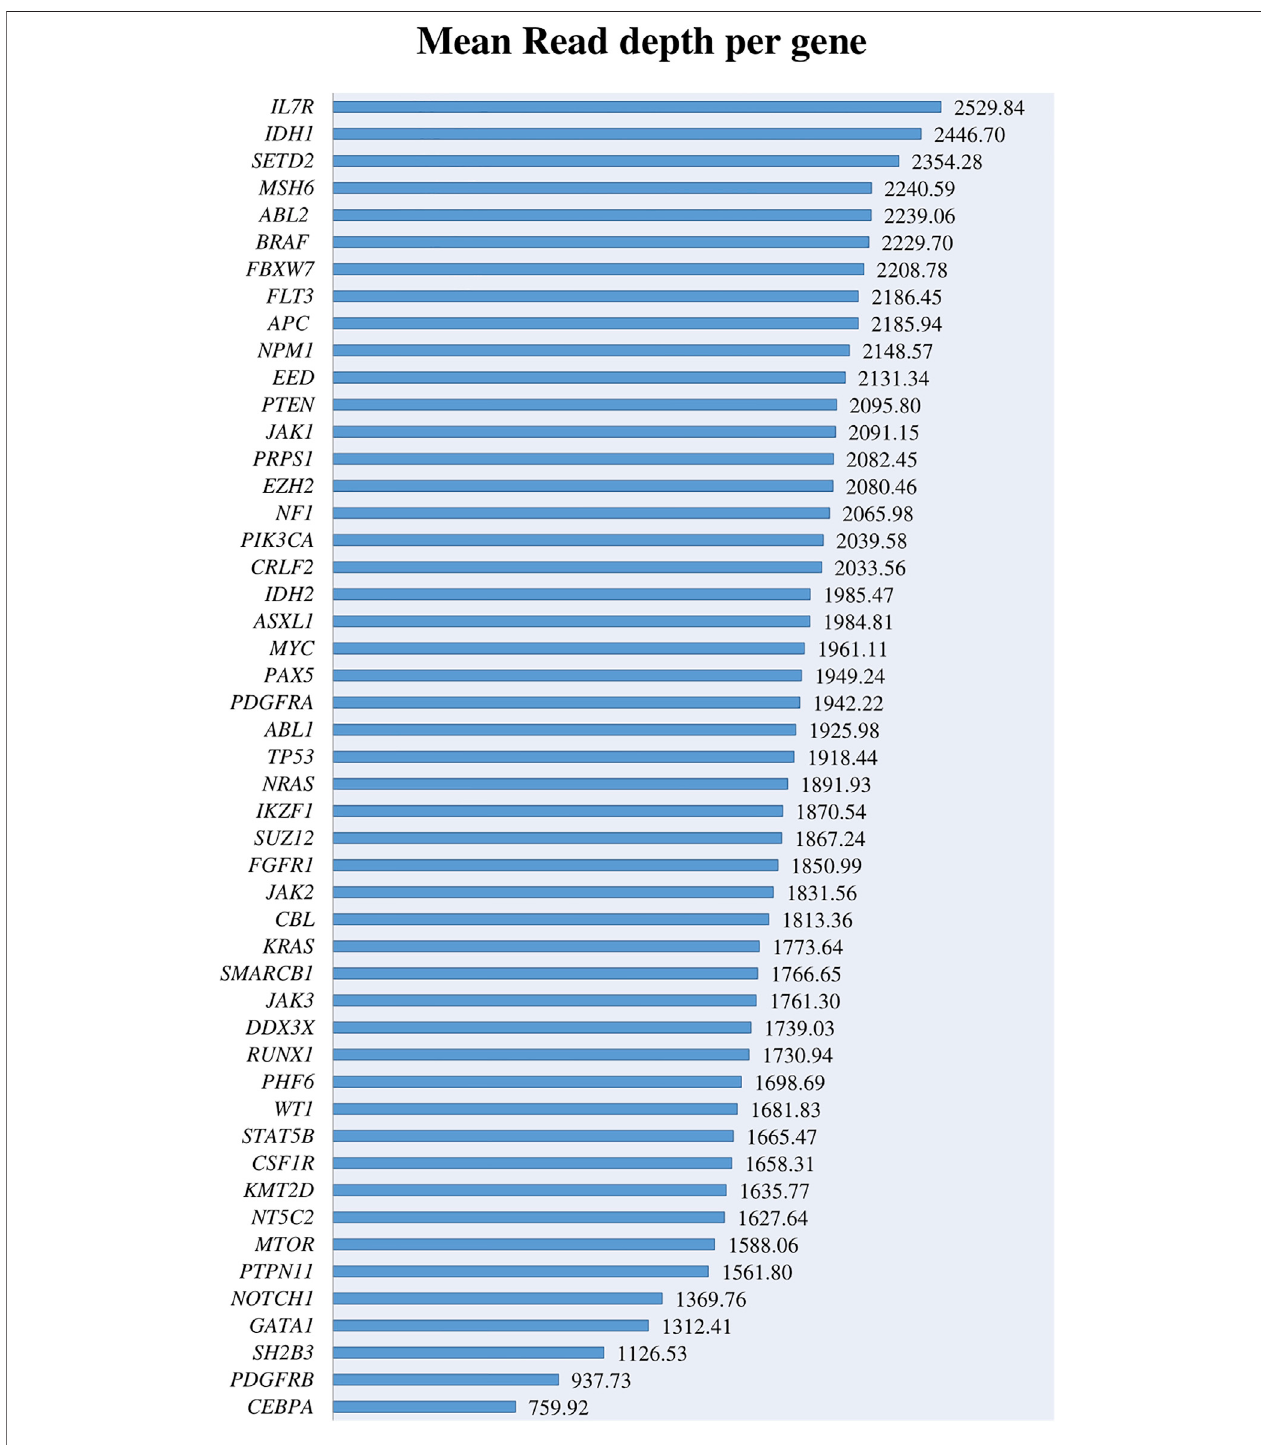
FIGURE 1 | Mean read depth obtained for the different leukemia-related